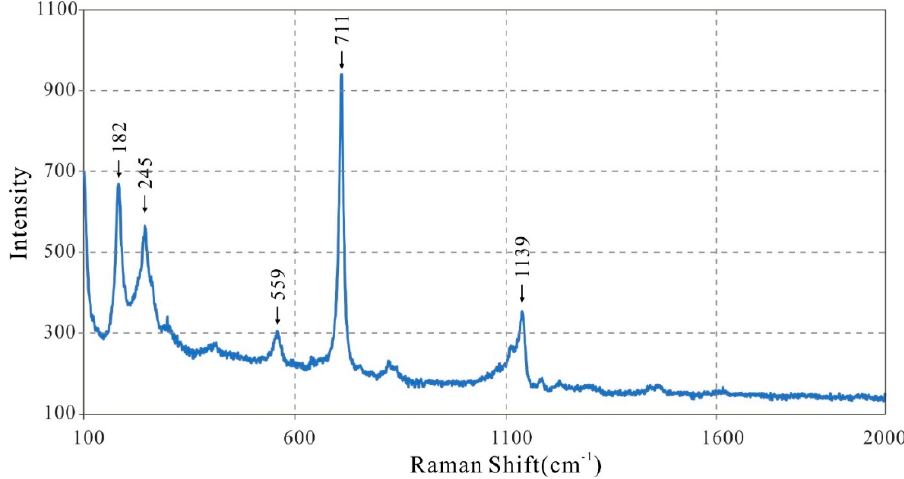
Figure 3. Raman spectra of fluorluanshiweiite.